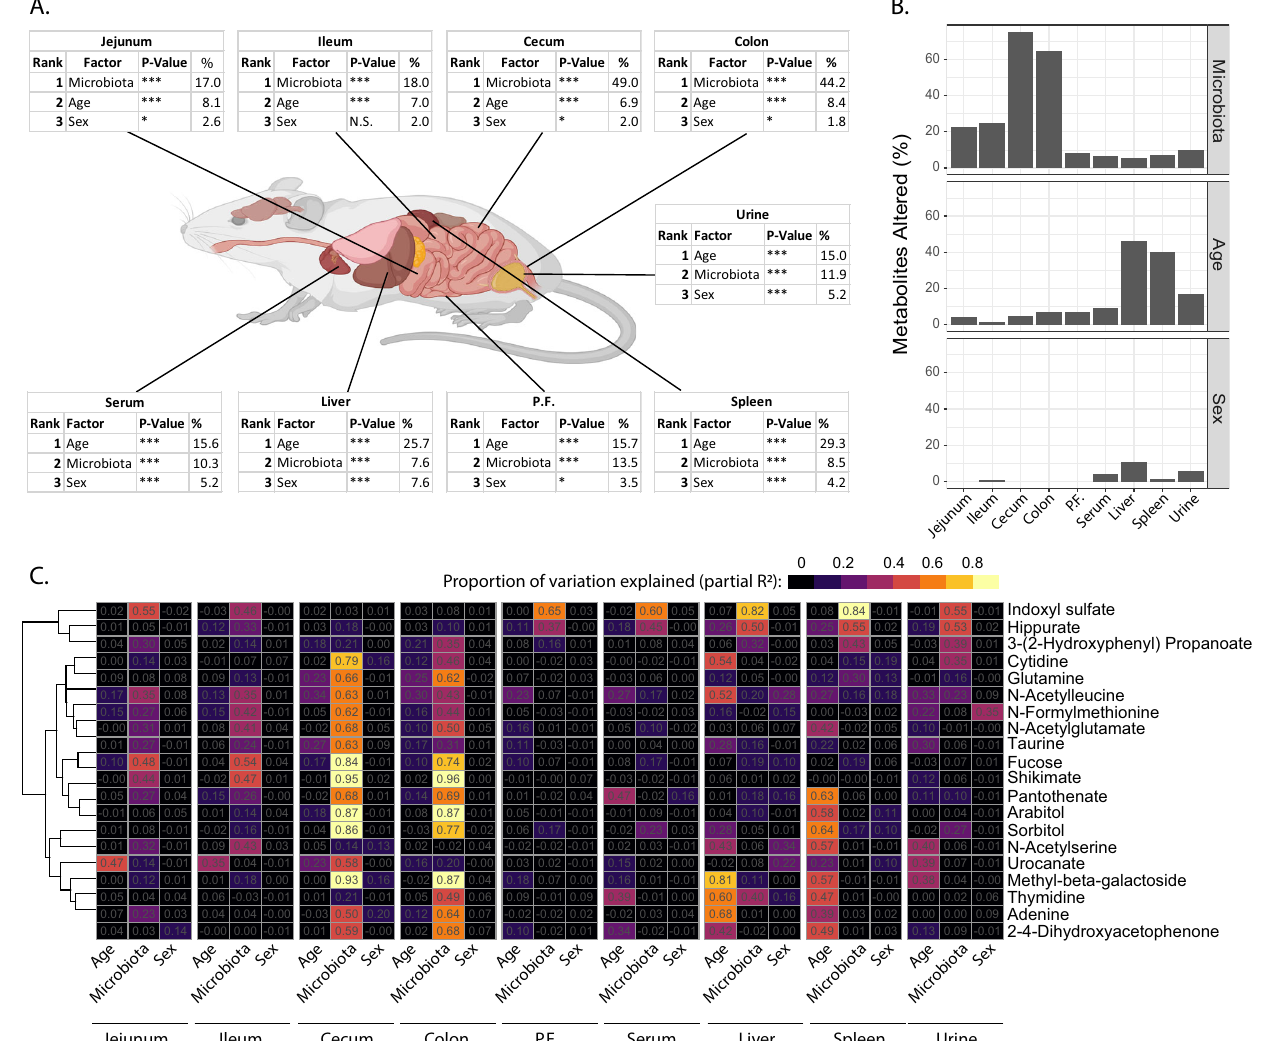
Fig. 2 | Contribution of microbiome, age, and sex to metabolism. A Estimated proportion of variation explained by microbiota, age and sex in each site sampled based on PERMANOVA statistics. B Proportion of metabolites altered ( P Adj <0.05) by microbiome, age, and sex at each site. C Partial R 2 showing the relative con- tribution of age, microbiota, and sex in explaining the variation in metabolite abundance at each site. Metabolites shown are the 20 metabolites where the most